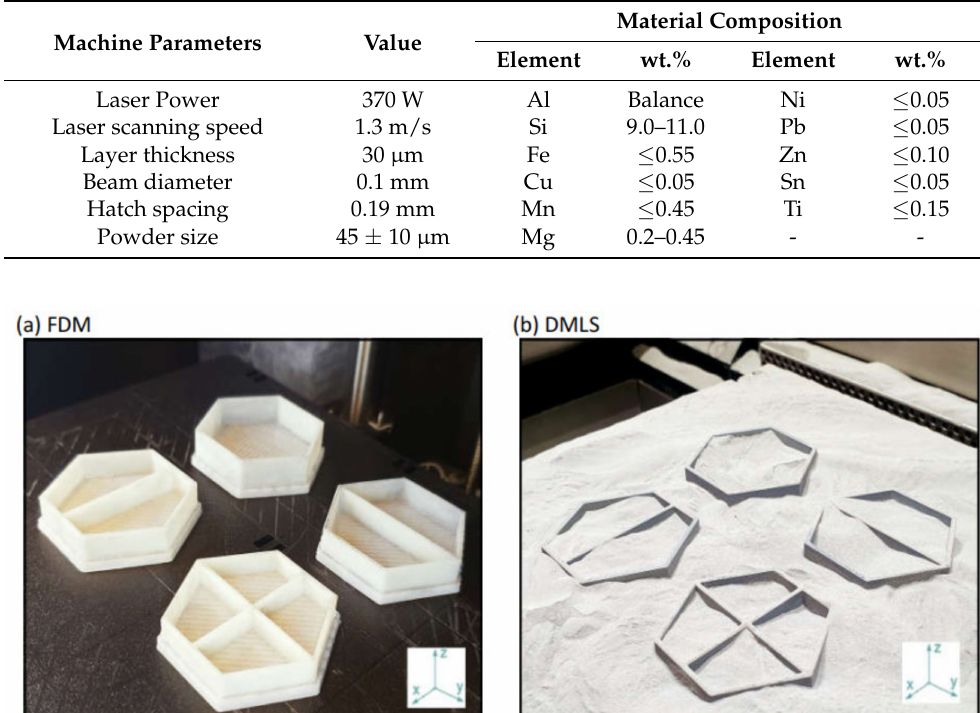
Figure 2. Geometrical configurations of the four hexagonal cells; ( a ) Control without stiffening, ( b ) cell with beam support, ( c ) cell with column support, and ( d ) cell with crossed support. The displayed dimensions are in mm. Table 2. EOS M280 3D machine parameters and material composition of AlSi10Mg powder.